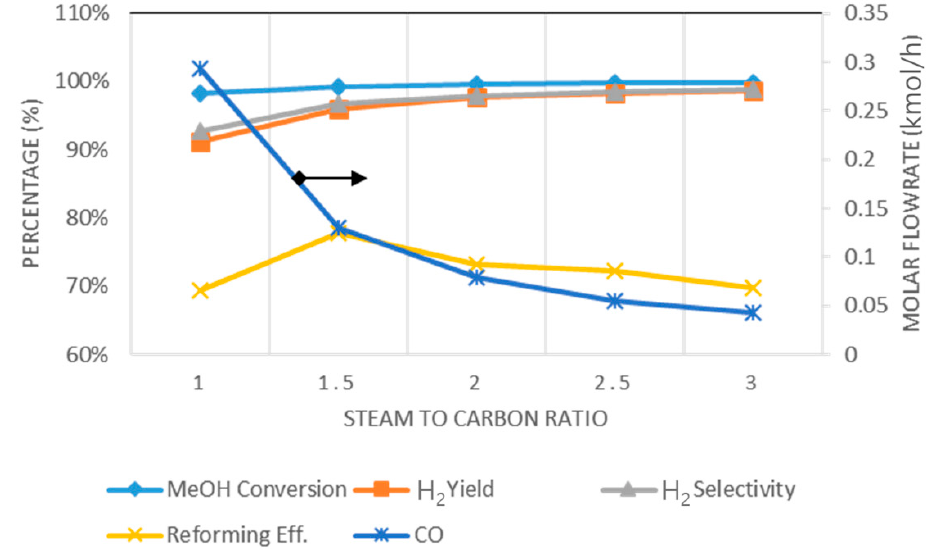
Figure 11. Effect of steam-to-carbon ratio (SCR) on MeOH conversion, H 2 yield, H 2 selectivity, reforming efficiency and CO flow rate.